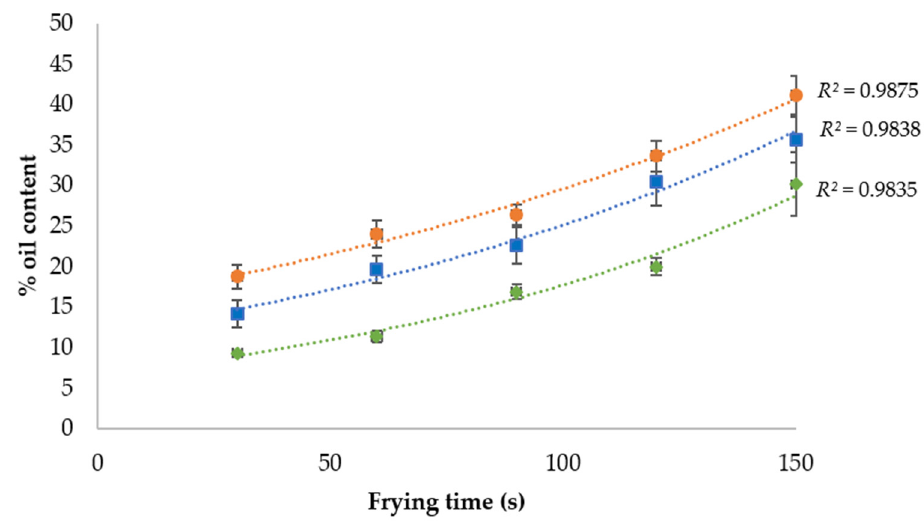
Figure 1. Uncoated mushroom slices’ oil capture kinetics during frying at 170 °C. Whole mush- Whole mushroom slice; room slice; mushroom stem; mushroom cap. mushroom